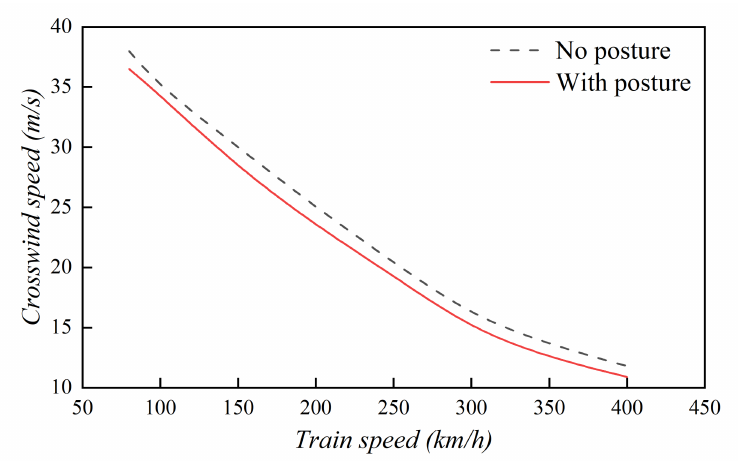
Figure 17. Running safety domain in terms of the relationship between the speed of crosswind and